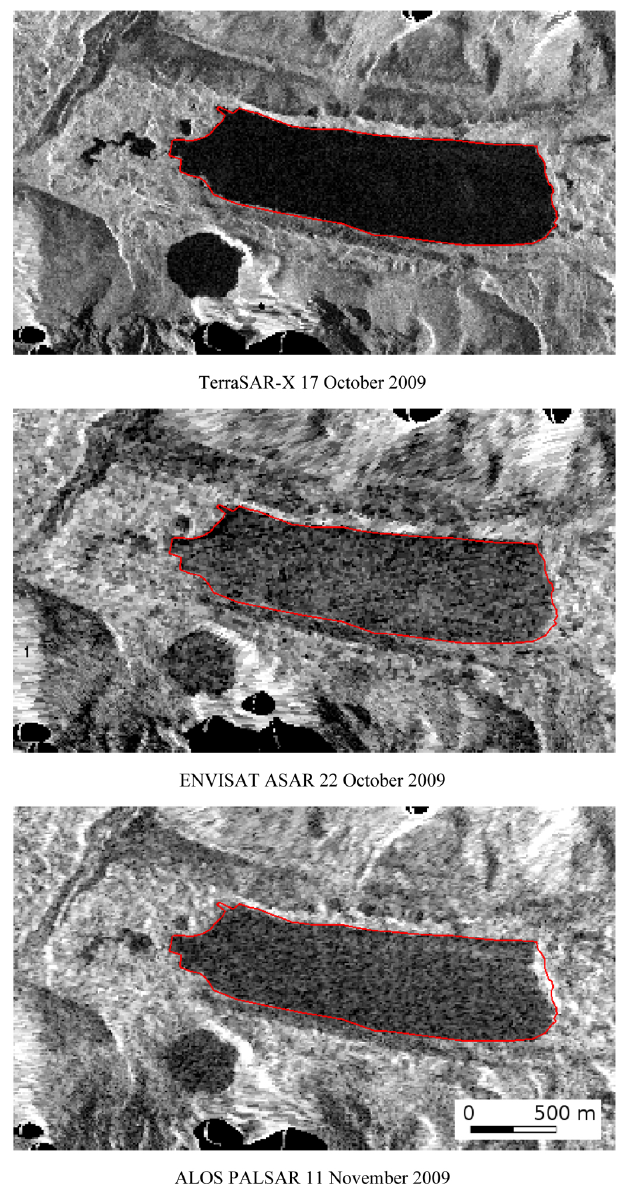
Fig. 7. TerraSAR-X and ENVISAT ASAR images of October 2009 and ALOS PALSAR acquisition of November 2009 of Imja Tsho. Lake outline is derived from the TerraSAR-X data. Areas affected by layover and shadow are masked in black.